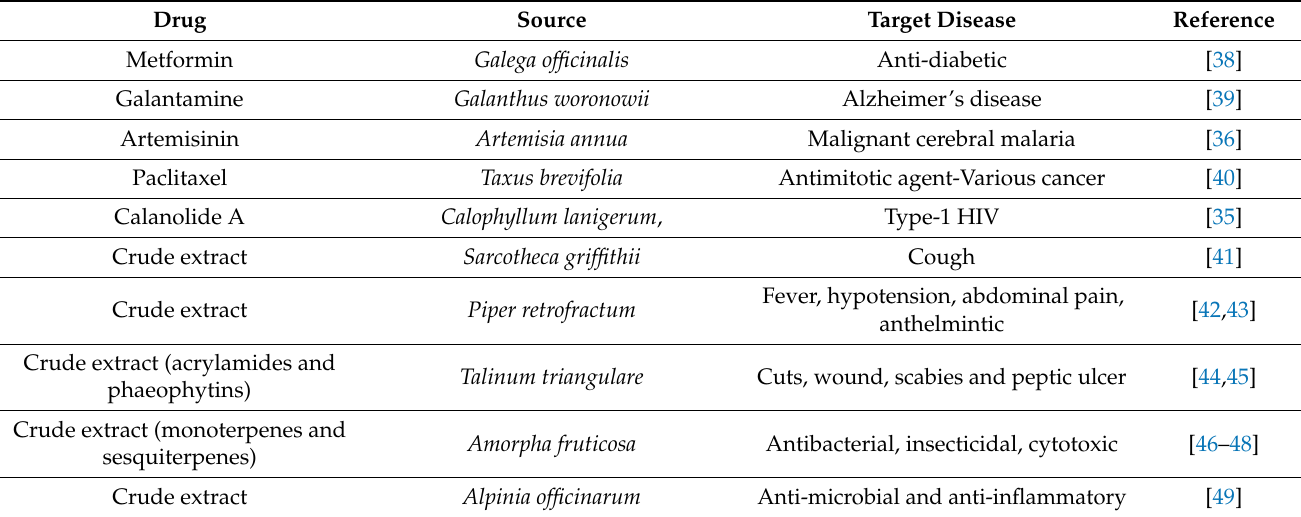
Table 1. Important plants species and their metabolites with medicinal effects.